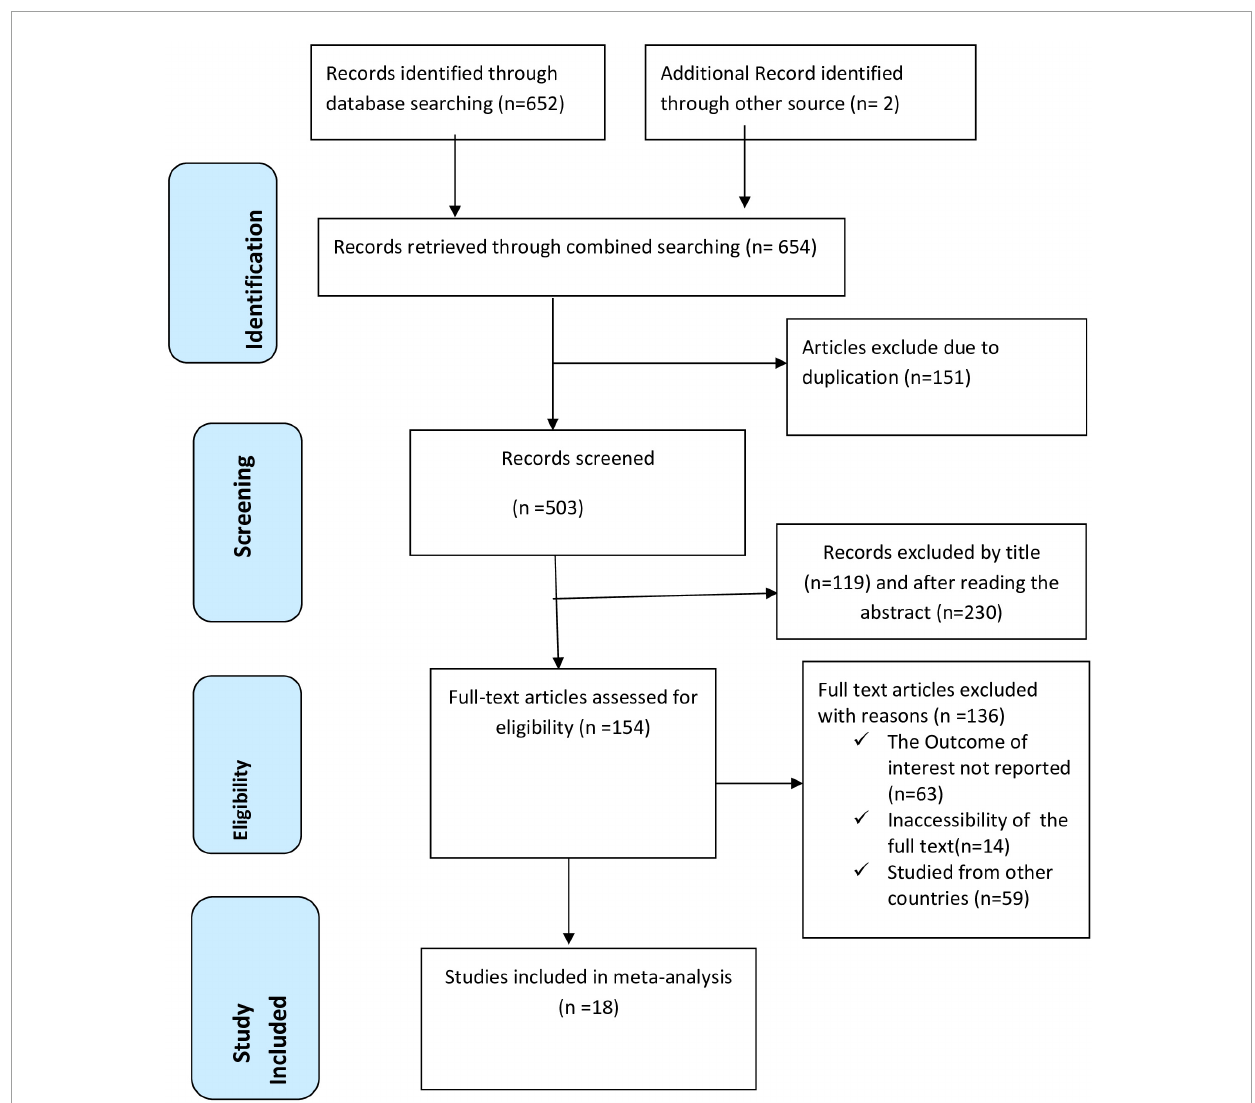
FIGURE1 PRISMA flow chart displays the article selection process for the prevalence of disrespect and abuse of women during childbirth in East